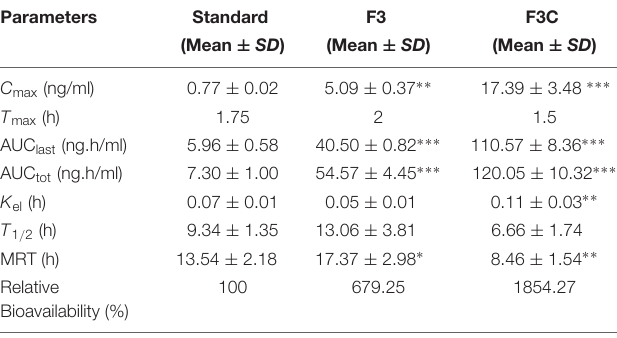
TABLE 2 | Pharmacokinetic profile of developed nanoparticles.